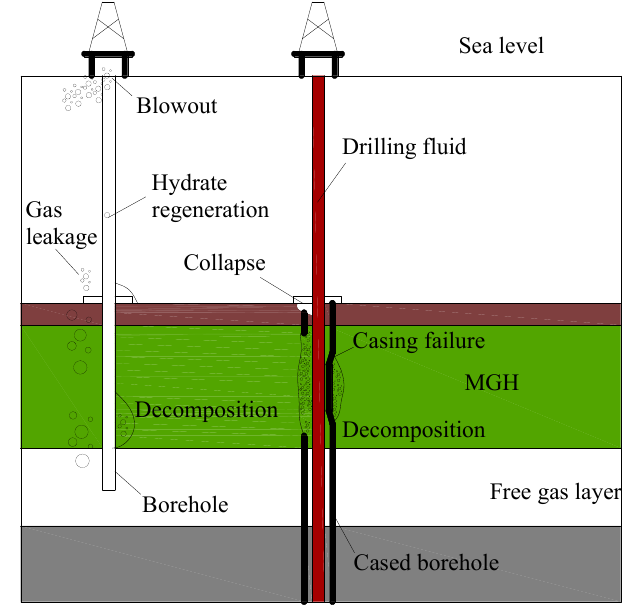
Figure 8. Sketch of drilling engineering hazards [38].